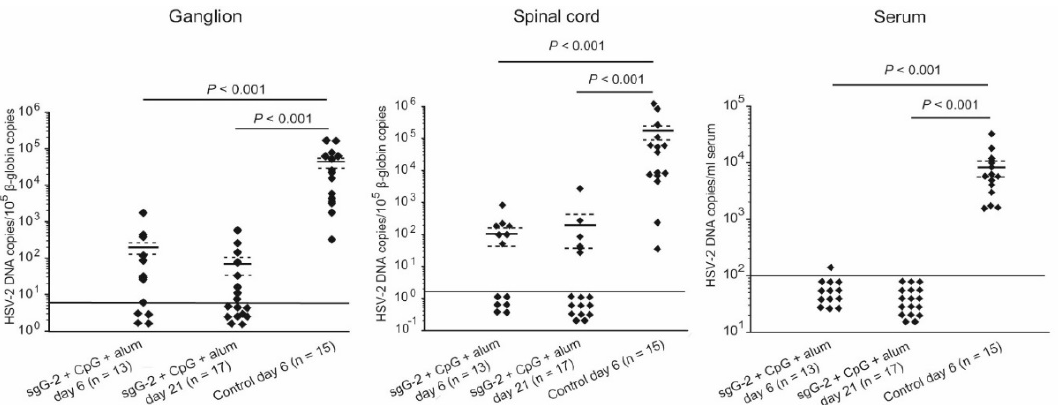
Figure 5. sgG ‐ 2 + adjuvant i.m. immunized C57BL/6 mice presented low amounts of HSV ‐ 2 DNA in blood and nervous tissue at day six or at day 21 post challenge as compared with PBS immunized control mice. HSV ‐ 2 DNA was quantified by real ‐ time PCR, and samples of the dorsal root ganglia and spinal cord were standardized to cellular β‐ globin genome copies. The detection limits of 5 HSV ‐ 2 DNA copies/10 5 β‐ globin copies per ganglion, and 1.8 HSV ‐ 2 DNA copies/10 5 β‐ globin copies for spinal cords, are indicated as long solid lines. The detection limit was 100 HSV ‐ 2 DNA copies/mL serum. Negative samples are indicated as dots below the detection limit. Data are shown from two separate experiments. Mean values (short solid lines) ± SEM (dashed lines) are indicated.